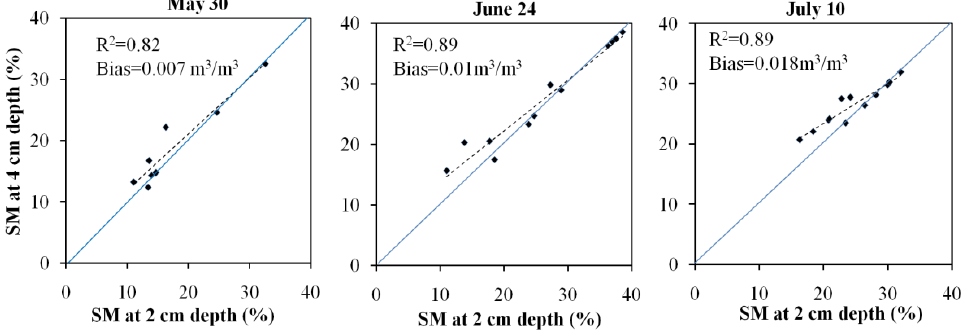
Figure 3. Scatters of SM measurements at a depth of 2cm versus that of 4cm. The measurements at 2 cm and 4 cm corresponding to ASTER overpass were provided by automatic meteorological stations (AWSs) [63,64]. There were 8, 12, 12